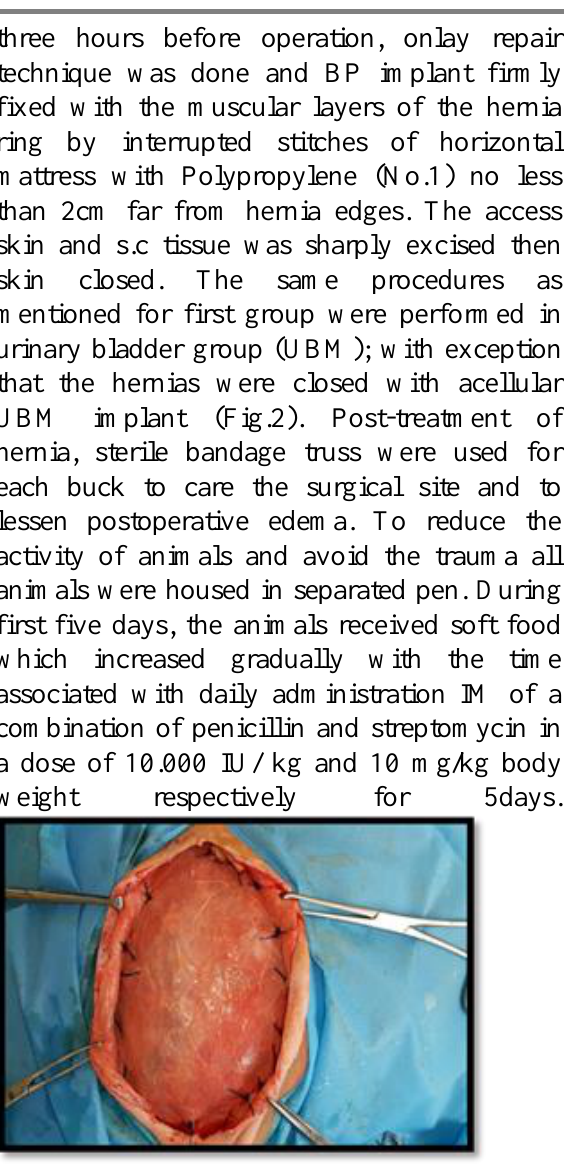
Figure 2: Shows the onlay fixation of the UBM sheet with interrupted horizontal mattress using Polypropylene (No.1). Table,1: Histopathological scores of progression of healing process at the site of hernias (11). scores 0 1 2 Zero cells in contact Cells contact periphery, no with penetration into Scaffold.